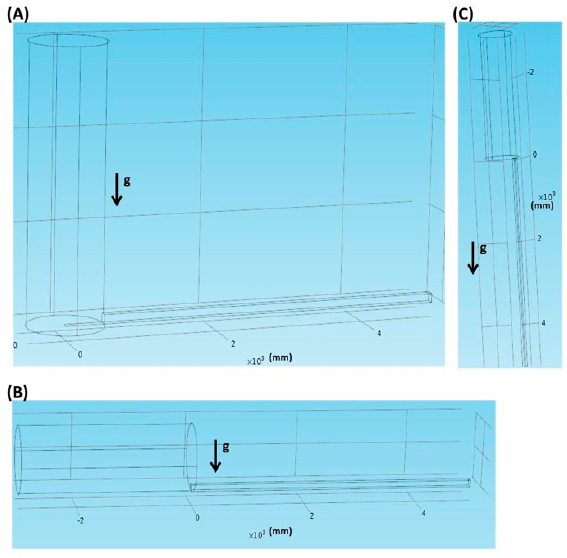
Figure 6. Different inlet geometries. ( A ) The vertical inlet; ( B ) The parallel inlet; ( C ) The vertically parallel inlet.